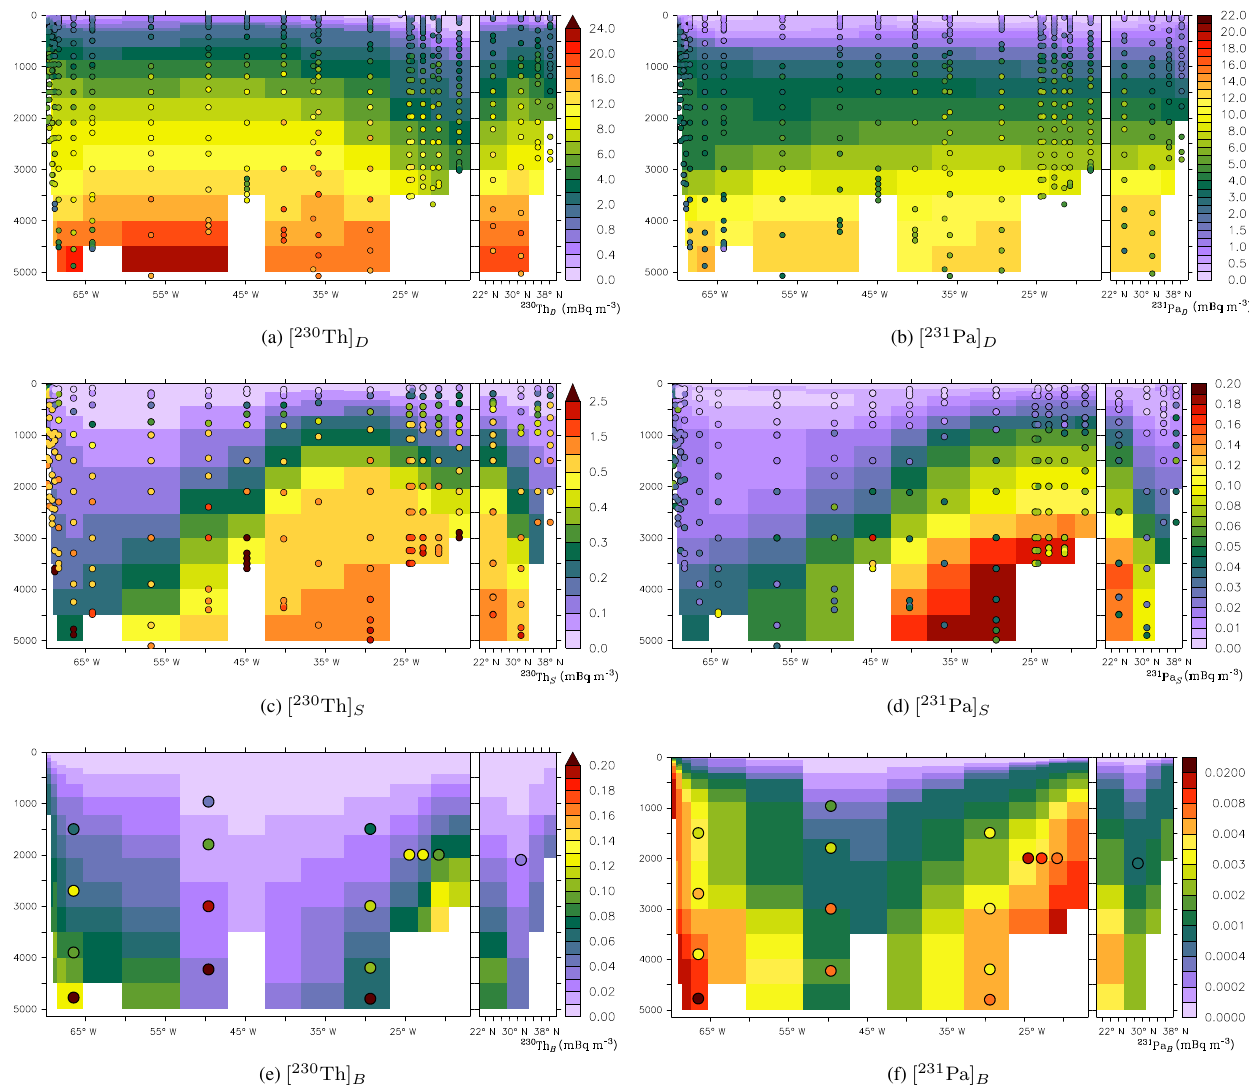
Figure 8. Radionuclide concentrations at the GA03 North Atlantic GEOTRACES transect. Panels (a) and (b) display dissolved concen- trations, panels (c) and (d) show the amounts on small particles, and panels (e) and (f) those on big particles. Everything is in mBqm − 3 . Observations (Hayes et al., 2015a) are shown as coloured